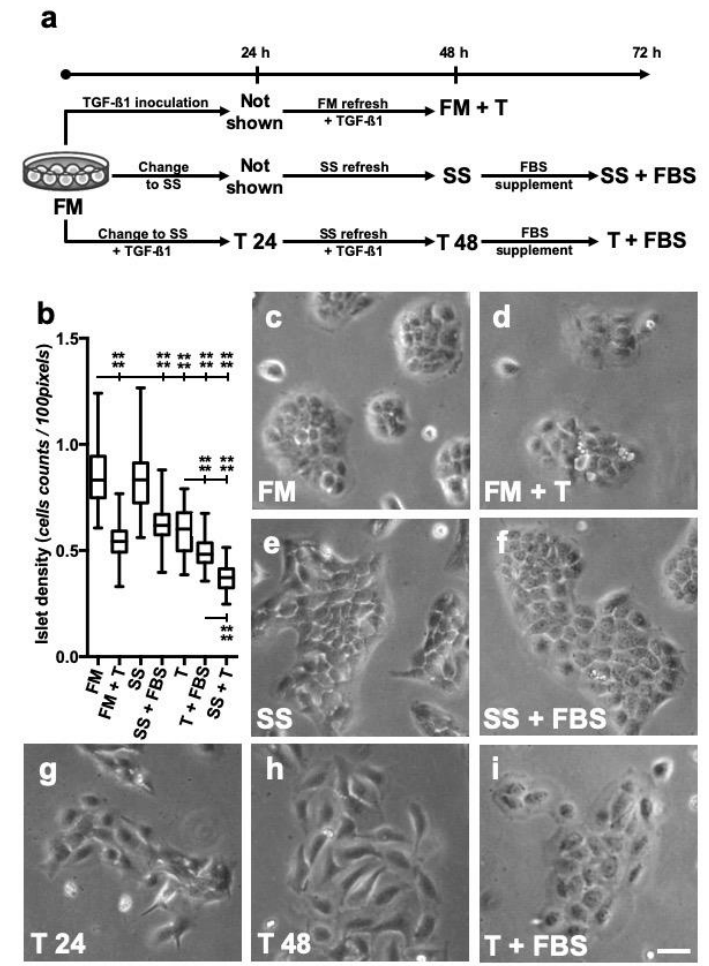
Figure 1. Continuous TGF- β 1 treatment causes unique phenotype changes in HaCaT cultured in